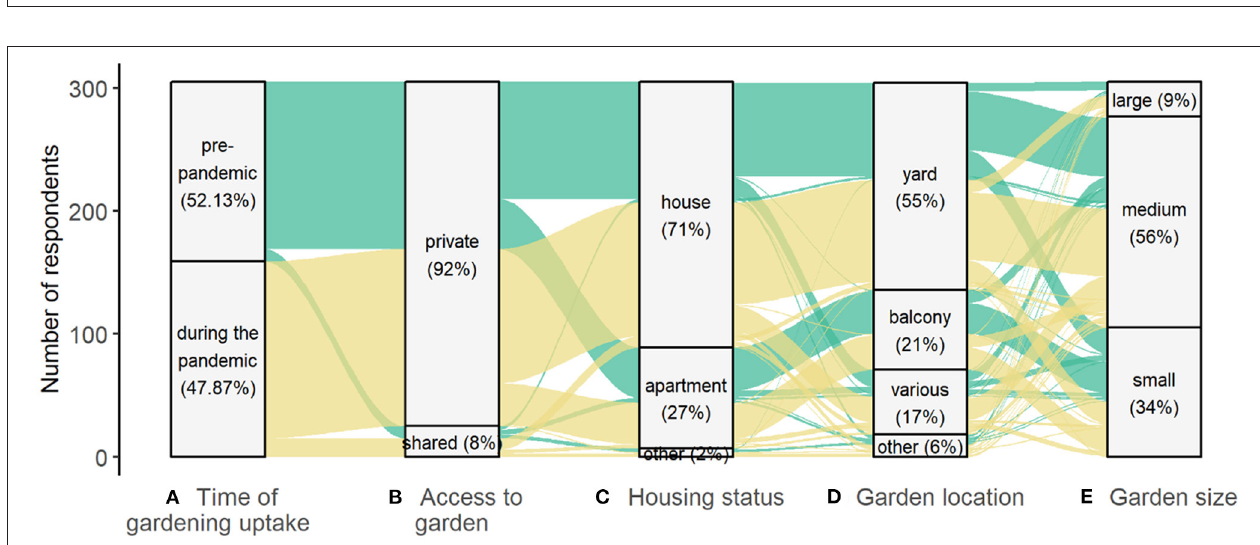
FIGURE 4 | Physical characteristics of the respondents’ gardens. Colored lines indicate the proportion of respondents who started gardening pre-pandemic (yellow) or during the pandemic (green). There were no significant differences according to the time of gardening uptake in relation to any of the displayed garden characteristics. (A) Time of gardening uptake. (B) Access to garden. (C) Housing status. (D) Garden location. (E) Garden